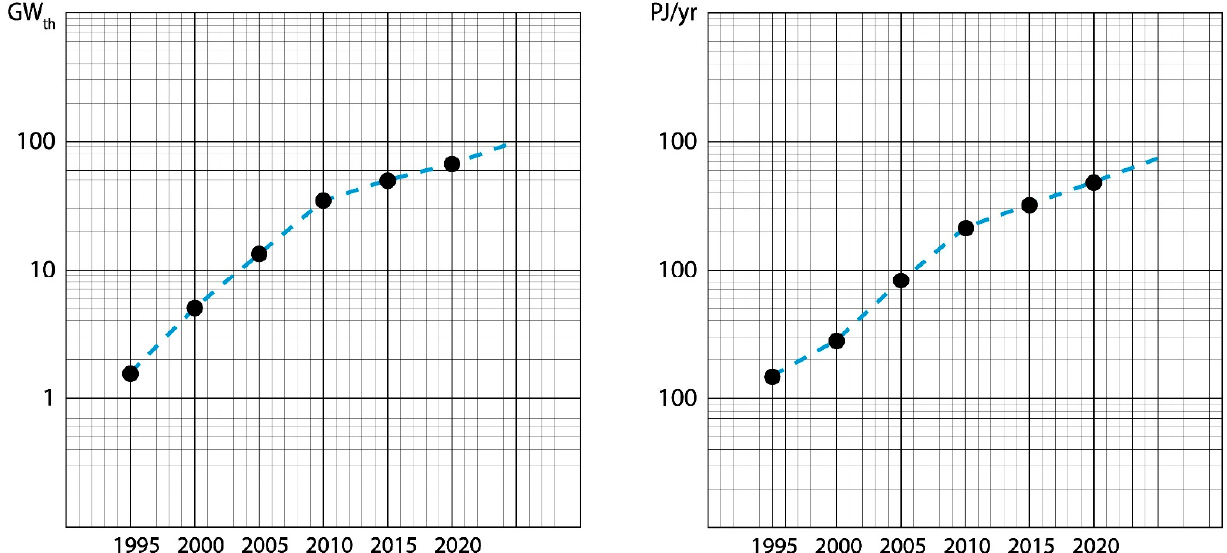
Figure 1. ( Left ) Worldwide installed capacity (GWt) of geothermal heat pumps. Annual growth rate 1995–2010 19.4%, and 2010–2020 8.5%. Data from [3] are plotted. ( Right ) Worldwide use for heating (PJ/year) of geothermal heat pumps. Annual growth rate 1995–2010 17.4%, and 2010–2020 11.0%. Data from [3] are plotted.